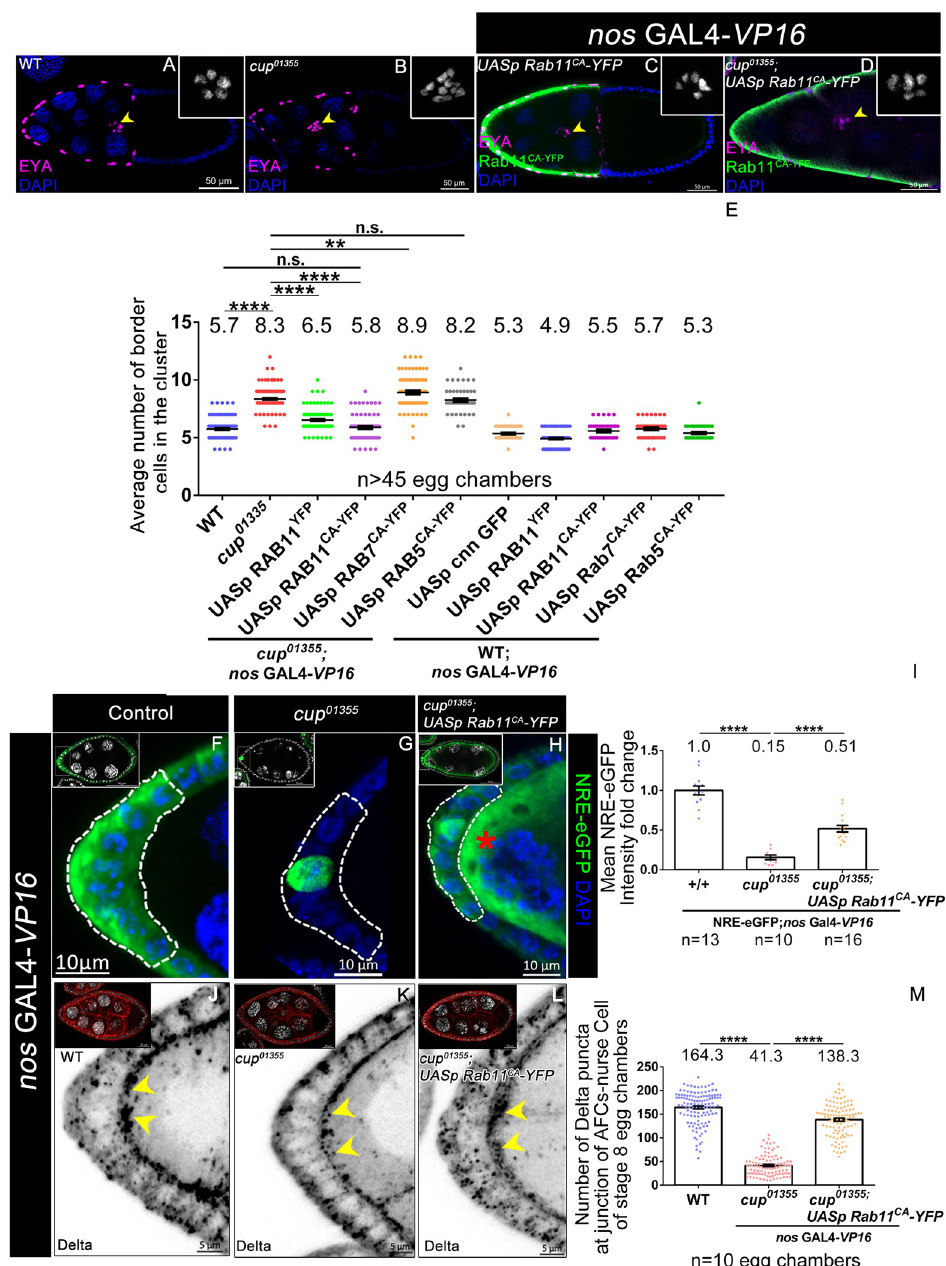
Fig 5. Overexpression of Rab11CA limits the border cell fate in the Cup mutant. (A-E) Stage 10 egg chambers of indicated genotypes stained with EYA (magenta), DAPI (blue, grey in inset) and YFP (green). yellow arrowheads mark the border cell cluster. Number of border cells is rescued when Rab11 CA is overexpressed in the nurse cells of cup 01355 egg chambers. ���� indicates a p value < 0.0001 (Student t-test). �� indicates a p value < 0.01 (Student t-test). “ns” indicates statistically not significant. (F-I) Stage 8 egg chambers of indicated genotypes. White dotted line outlines the Anterior follicle cells. NRE-eGFP (green) and DAPI (blue, white in inset). (I) NRE-eGFP intensity fold change with respect to the control is partially rescued when Rab11 CA is overexpressed in nurse cells of cup 01355 egg chambers as compared to cup 01355 mutant egg chambers alone. Red asterisk in nurse cells indicates tagged YFP expression when Rab11 CA is over expressed with germline specific nos GAL4 - VP16 . ���� indicates a p value < 0.0001 (Student t-test) (J-M) Stage 8 egg chambers of indicated genotypes. Yellow arrowheads mark the Delta puncta at the junction of anterior follicle cell and nurse cells, Delta (black, red in inset), and DAPI (white). (M) Quantification indicates that Number of Delta particles at the junction of anterior follicle cell and nurse cells is partially rescued when Rab11 CA is overexpressed in the nurse cells of cup 01355 egg chambers as compared to that observed in cup 01355 egg chambers